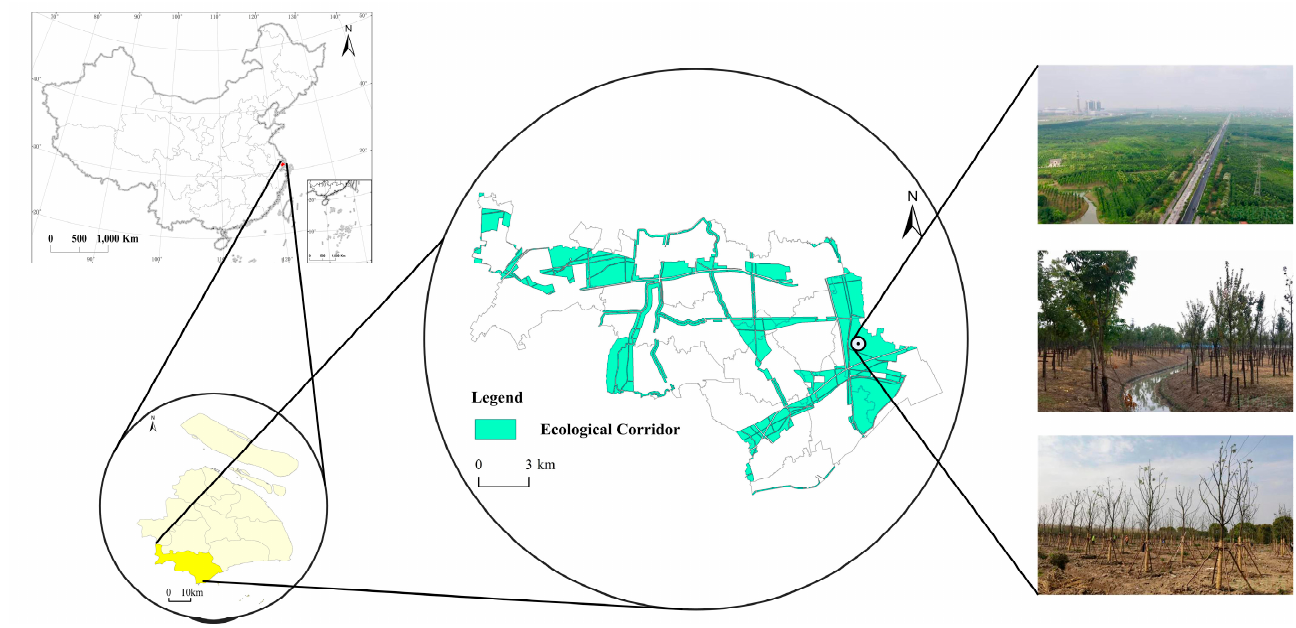
Figure 2. Location of the study area.